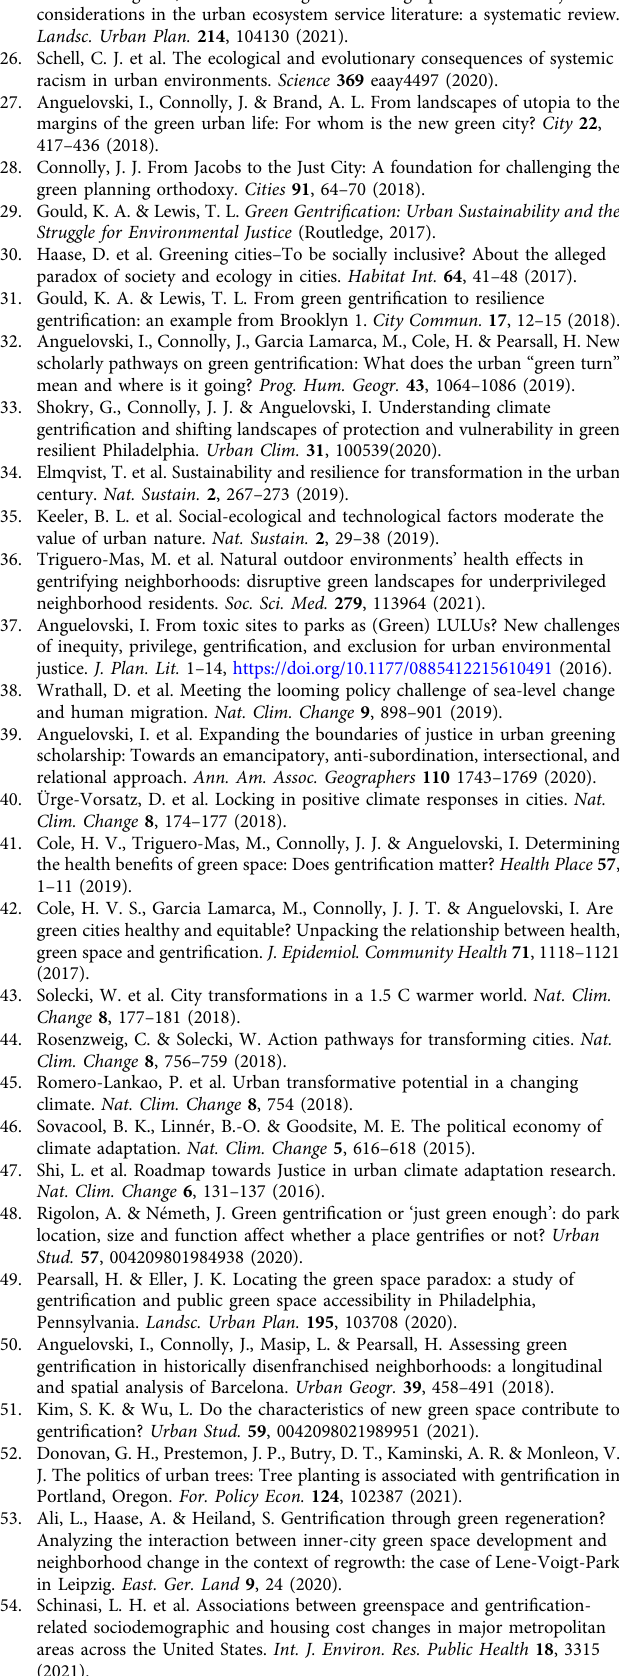
our demographic analysis was